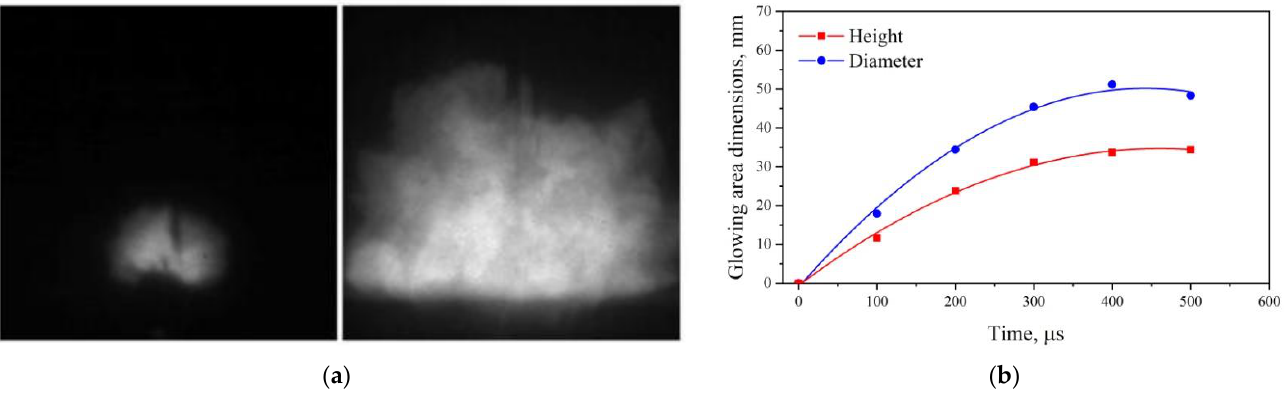
Figure 4. Combustion of Al – CuO mixture on a surface. ( a ) Typical photographs, 300 μs and 900 µs after ignition. ( b ) Expansion dynamics of glowing area.